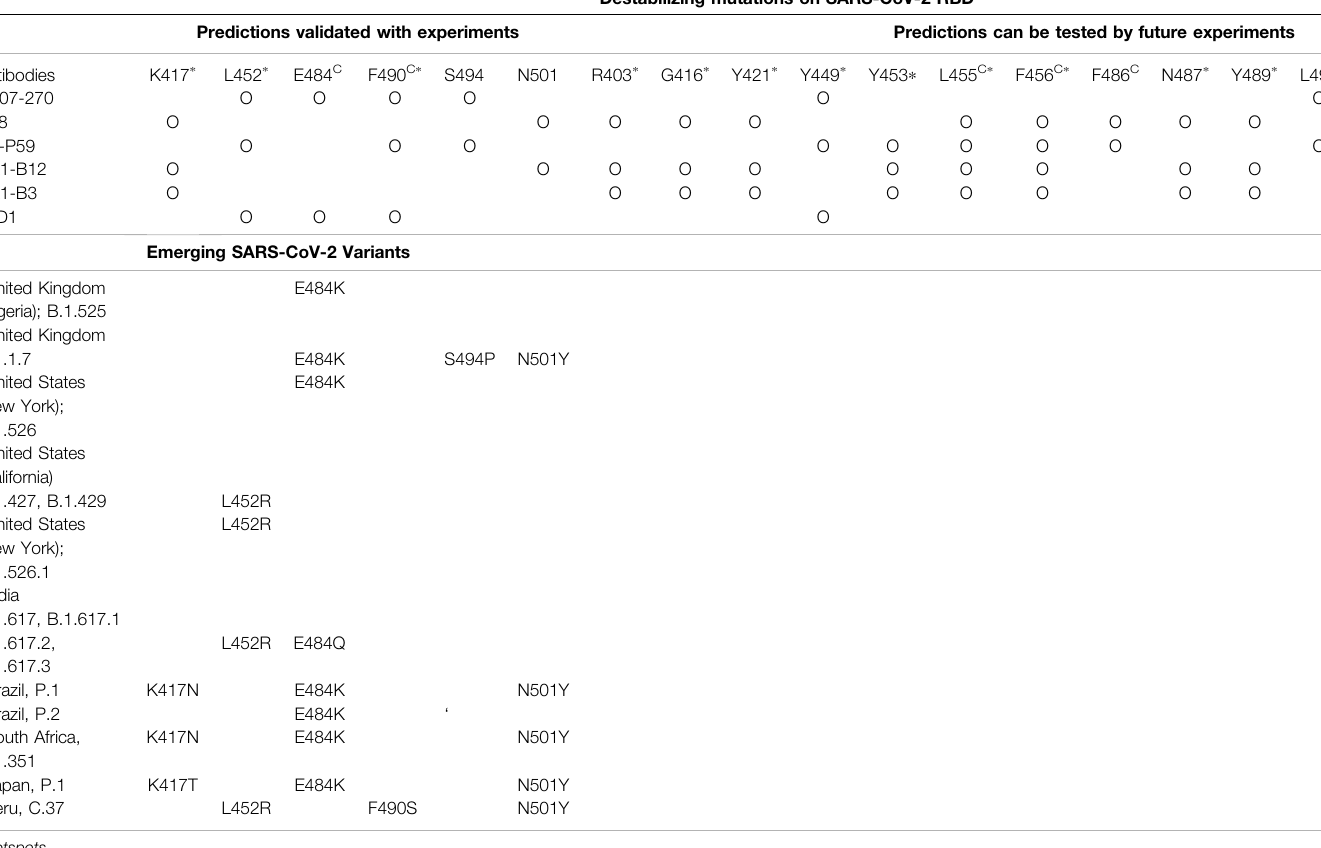
TABLE 1 | Functionally essential residues of the RBD mutations that confer the immune-escaping ability of SARS-CoV-2 in relation to neutralizing convalescent antibodies. Destabilizing mutations on SARS-CoV-2 RBD Predictions validated with